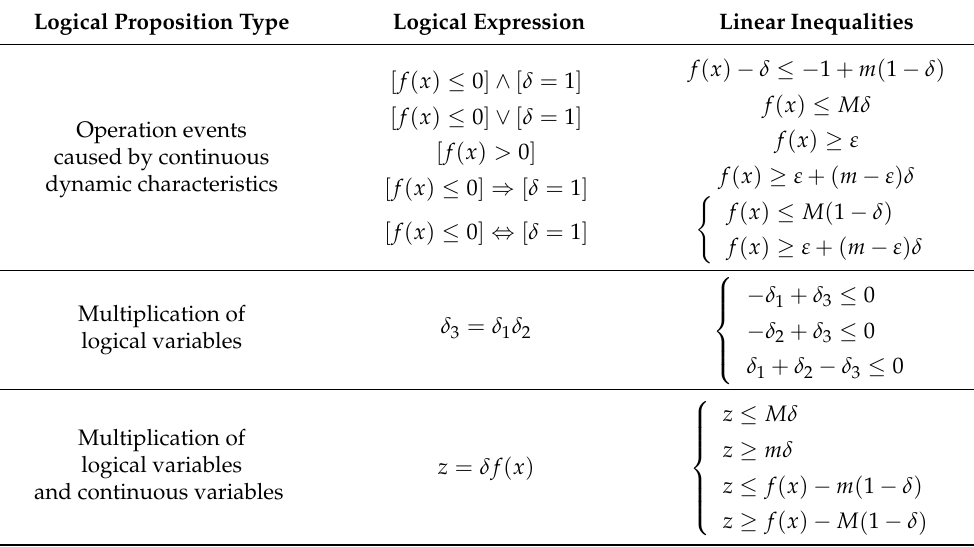
Table 1. Fundamental conversion rules of logical propositions to linear inequalities